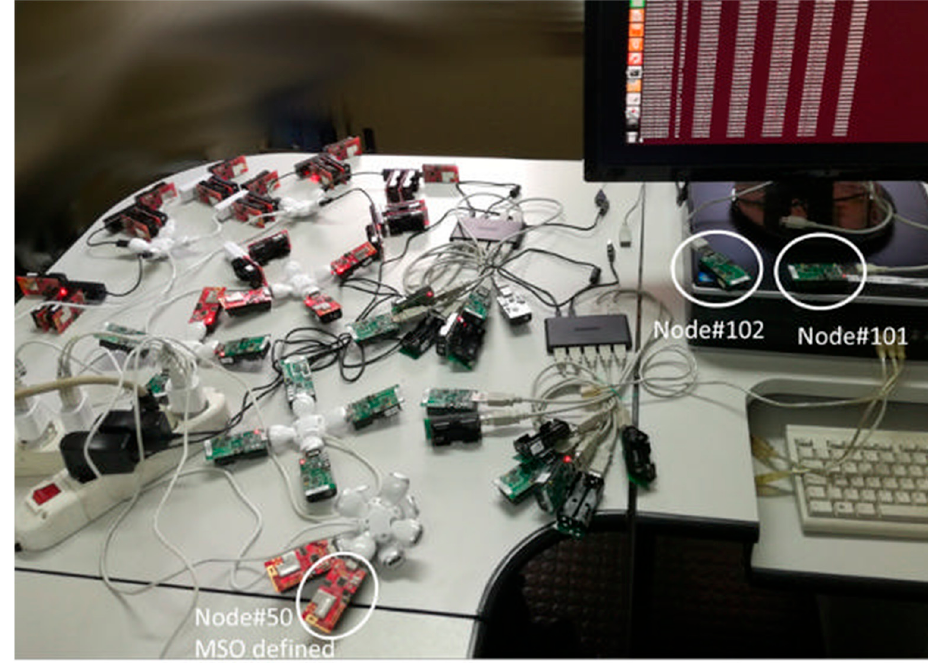
Figure 6. Experimental testbed.